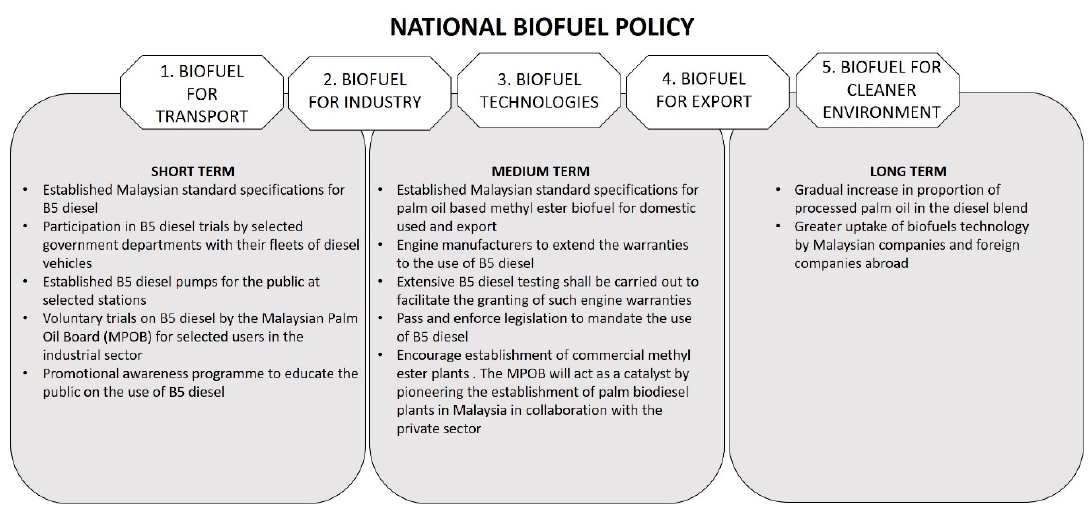
Figure 4. Strategic five thrusts of Malaysia’s national biofuel policy and implementation (Adapted from [24]).